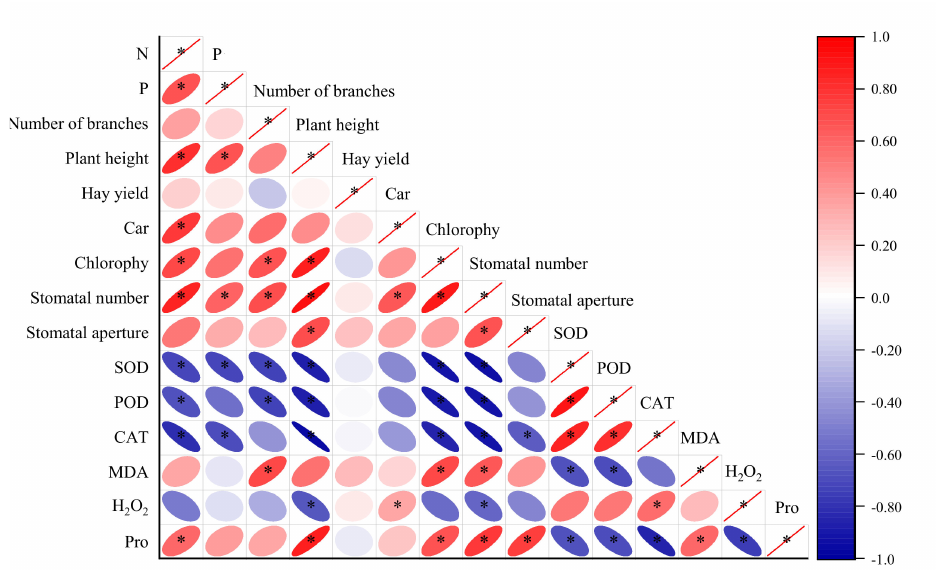
Figure 8. Correlation of physiological parameters, such as growth index and photosynthetic char- acteristics. Asterisks (* p < 0.05) indicate that there was significant